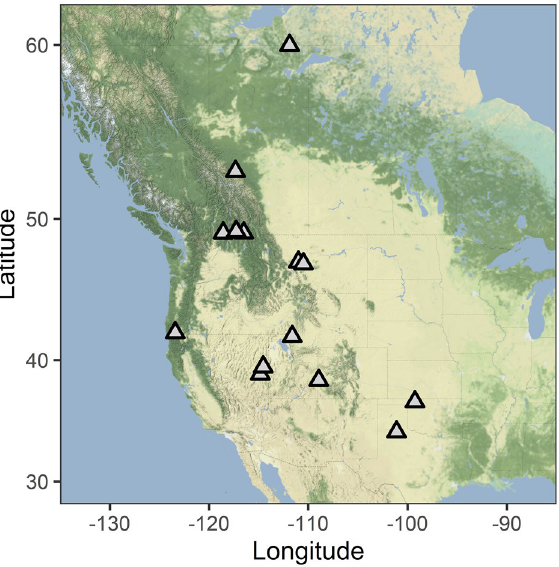
Figure 1. We collected data from hibernating bats at sites across the western half of Canada and the United States. The species studied at each site are indicated in Table 1. We do not report the names or precise locations to protect these sensitive sites. Map created with ggmap package in R 66 using map tiles from Stamen Design (maps.stamen.com; CC BY